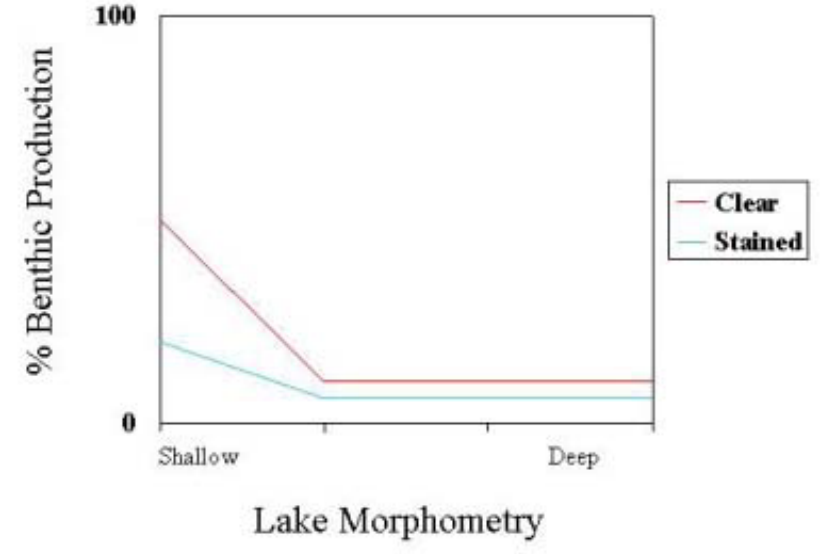
FIGURE 3. Conceptual relationship between lake morphometry and the relative contribution of benthic primary production. Note that the influence of lake morphometry is damped when water color is stained. See text for additional